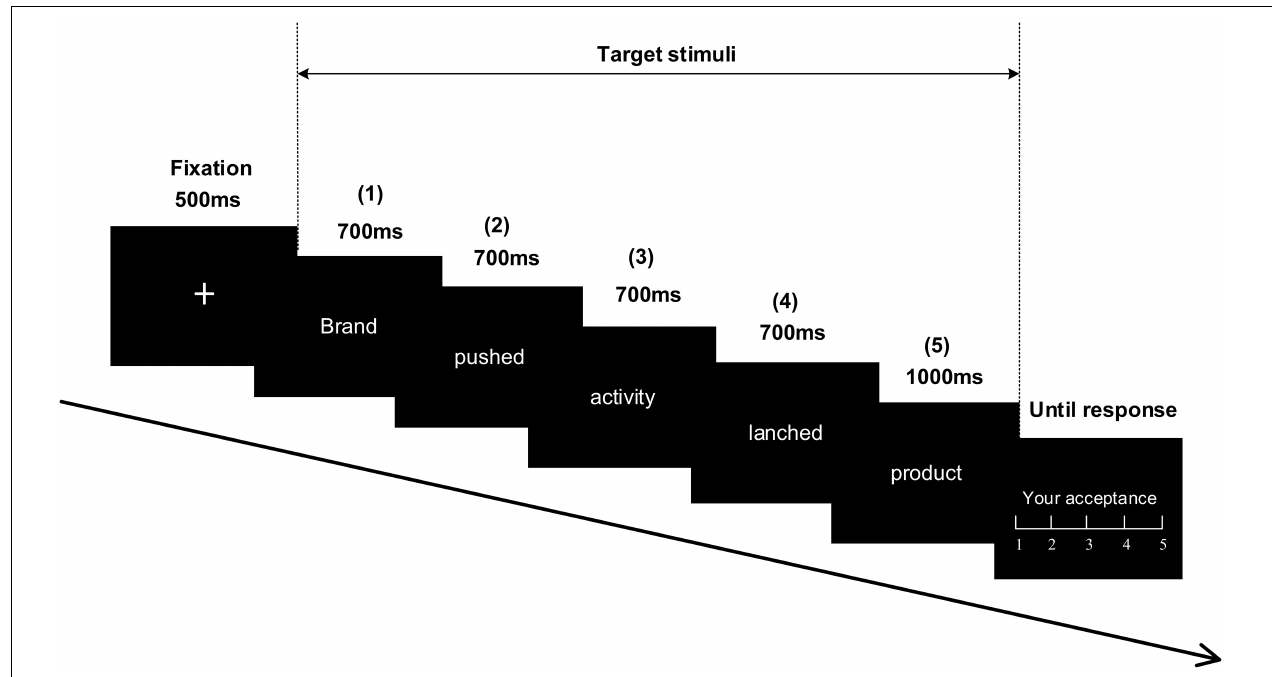
FIGURE 1 | Experimental procedure: participants were successively presented to a series of stimuli of which the five target stimuli formed as one sentence in Chinese. They were asked to press a button (1–5) based on their acceptance level toward the new product of a brand.